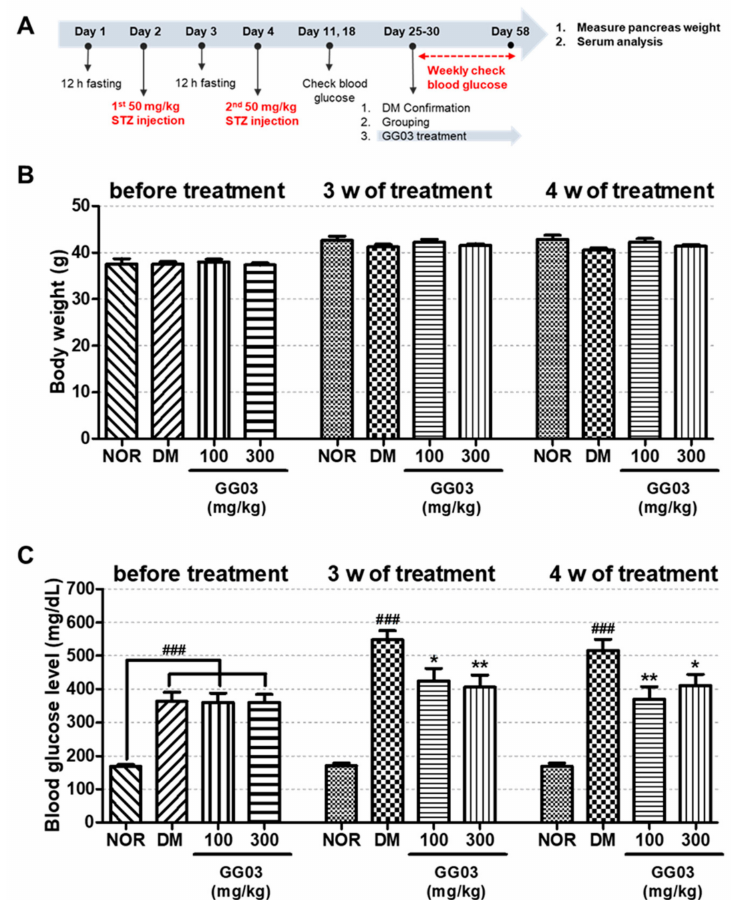
Figure 8. Body weights and glucose levels in diabetic mice. ( A ) Experimental scheme. ( B ) Body weight of each group. ( C ) Blood glucose level of each group. ( ### p < 0.001; compared to NOR), (* p < 0.05, ** p < 0.01; compared to DM).